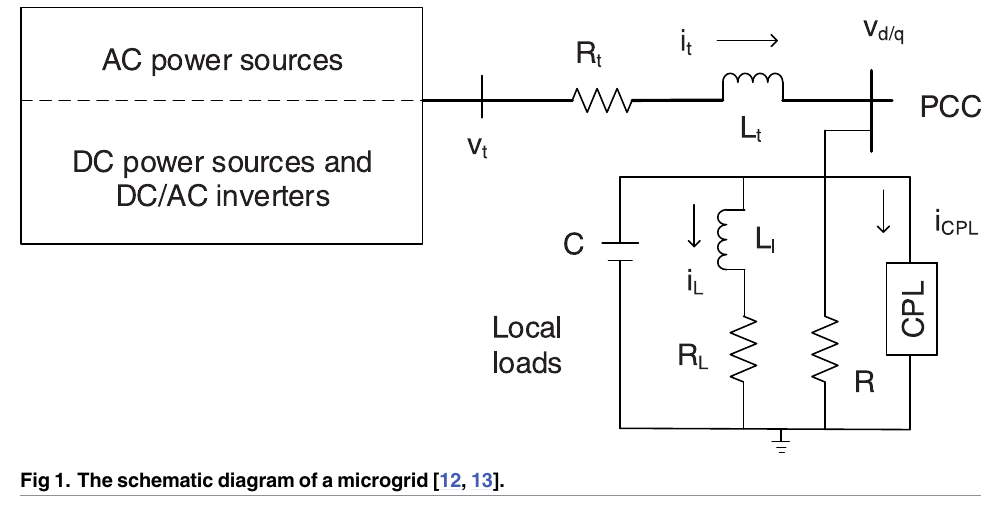
Fig 1. The schematic diagram of a microgrid [12,